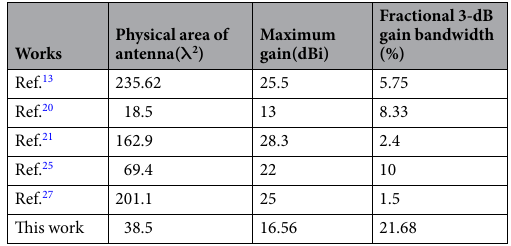
Table 1. Comparison of the measured performance of recently reported MAs.